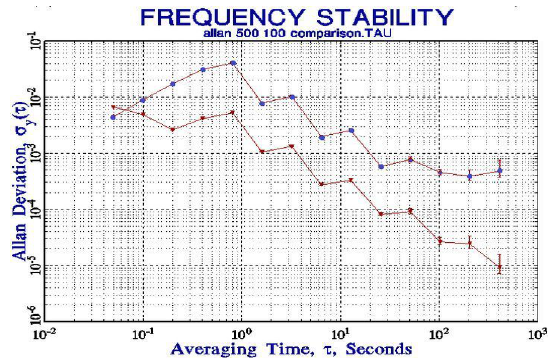
Figure 3: Allan deviation curves for compensated signals with a modulating frequency and amplitude of 300mHz (blue dots) and of 500mHz (red dots)